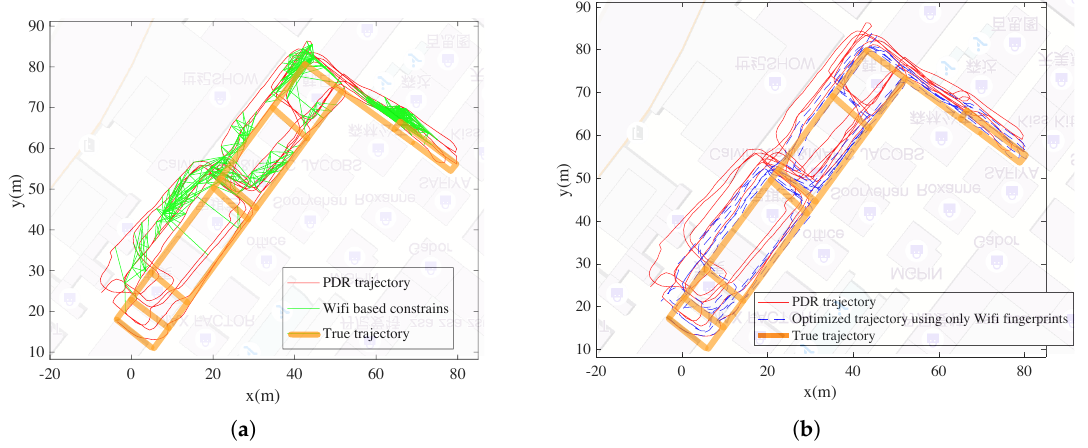
Figure 8. Results for fusing PDR trajectory and Wi-Fi fingerprints. ( a ) Wi-Fi-based constraints. ( b ) Optimized trajectory using Wi-Fi-based constraints.